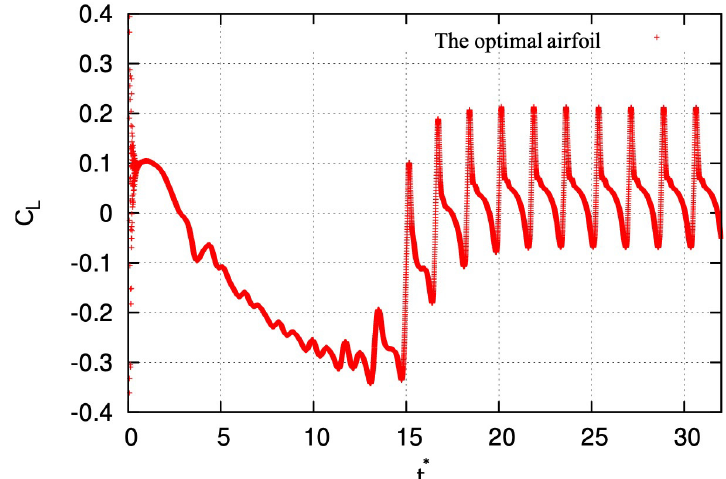
Figure 18. Time evolution of lift coefficient for the optimal airfoil at Re = 4000 and α = − 2 ◦ .